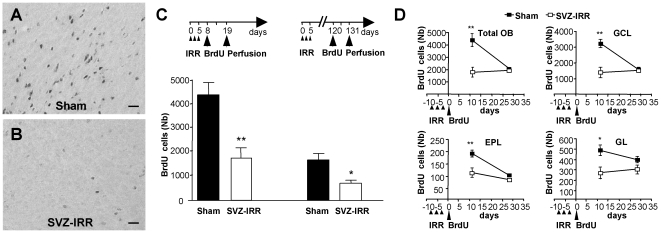
Irradiation reduced the recruitment of new neurons.(A, B) New cells were labeled with BrdU 3 days after the last focal irradiation and survival was determined 11 days later. Photomicrographs show OB coronal sections labeled with BrdU, for sham-treated and irradiated mice. (Scale bar: 30 µm). (C) New cells were labeled with BrdU 8 or 120 days after the first session of irradiation. The mean number of BrdU+ cells in the entire OB was determined for sham-treated and irradiated mice 11 days after the final BrdU injection. Student's t test; ** p<0.01. * p<0.05 (n = 3–6 mice). (D) BrdU+ cell number in the OB, including the GCL, EPL and GL, for sham-treated and irradiated mice, with BrdU injected 8 days after the first session of irradiation. Student's t test; ** p<0.01. * p<0.05 (n = 4–6).